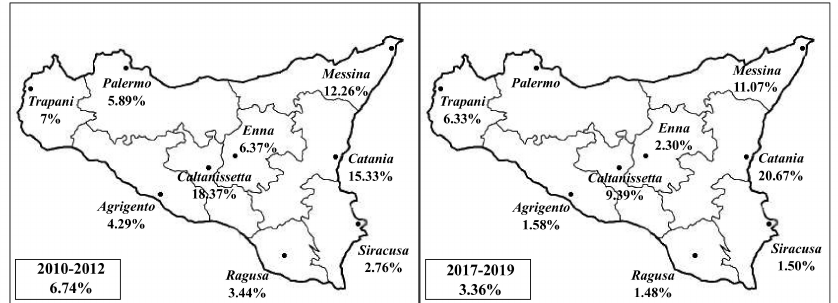
Figure 1. Bovine tuberculosis (bTB) prevalence rates recorded throughout the di ff erent provinces